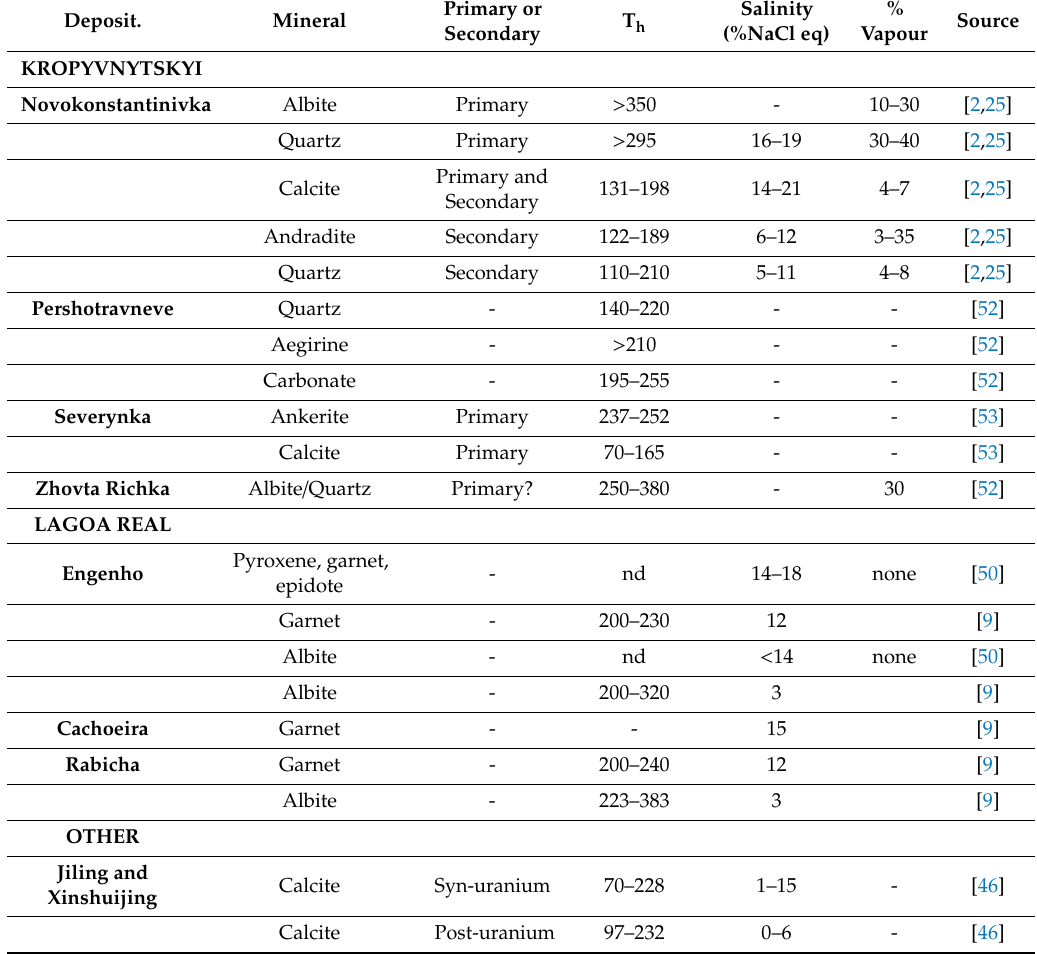
Table 3. Compilation of summary fluid inclusion data for shear-hosted uranium deposits.